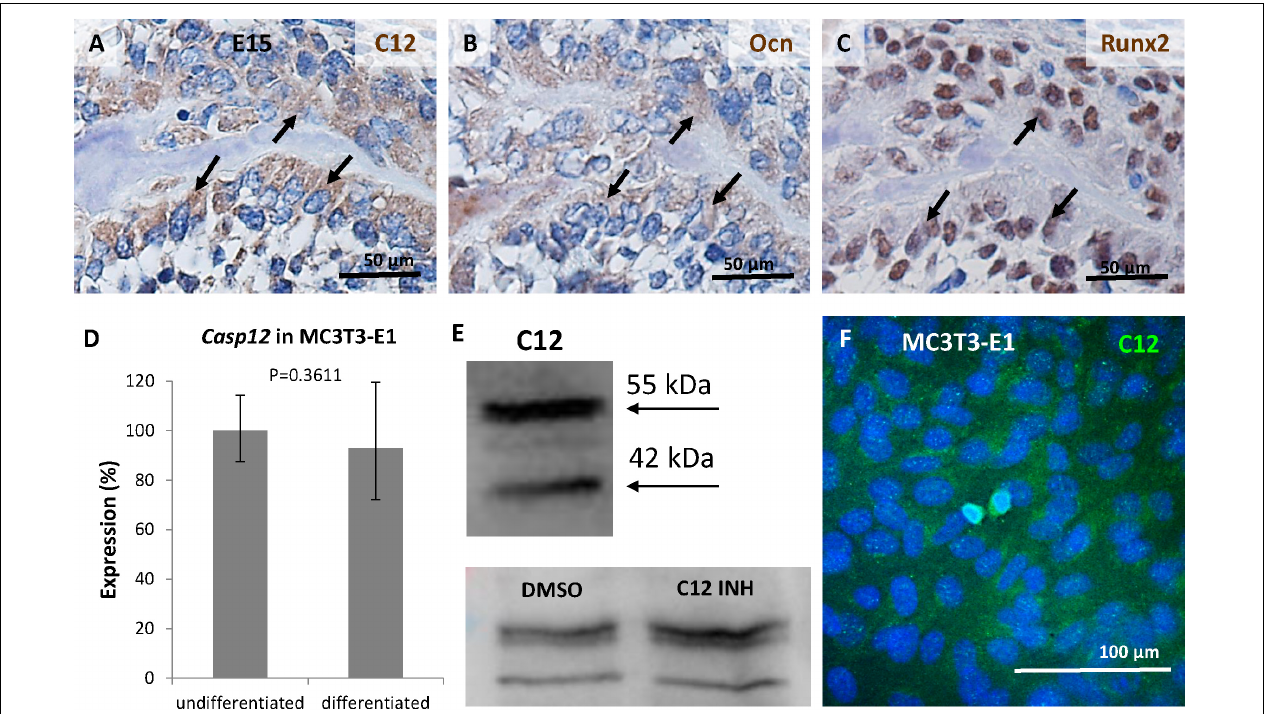
FIGURE 4 | Expression of caspase-12 in osteoblasts. Comparison of serial sections of the mouse mandibular bone at the prenatal/embryonic (E) day 15 showing co-localization of caspase-12 (A) with osteoblastic markers osteocalcin (B) and Runx2 (C) within the bone. Positive cells are brown, counterstained by hematoxylin (blue). Arrows point to cells in the same region. Scale bar: 50 µ m. Expression of caspase-12 in undifferentiated and differentiated MC3T3-E1 cells (D) showing stable expression of Casp12 after 21 days of differentiation. Western blot analysis (E) and immunofluorescence (F) confirmed the presence of caspase-12 protein in MC3T3-E1. E: 55 kDa-full length caspase-12, 42 kDa-cleaved caspase-12, DMSO: caspase-12 forms after DMSO treatment, C12 INH: caspase-12 forms after specific inhibitor treatment. F: Caspase-12 in green, DAPI in blue. Scale bar: 100 µ